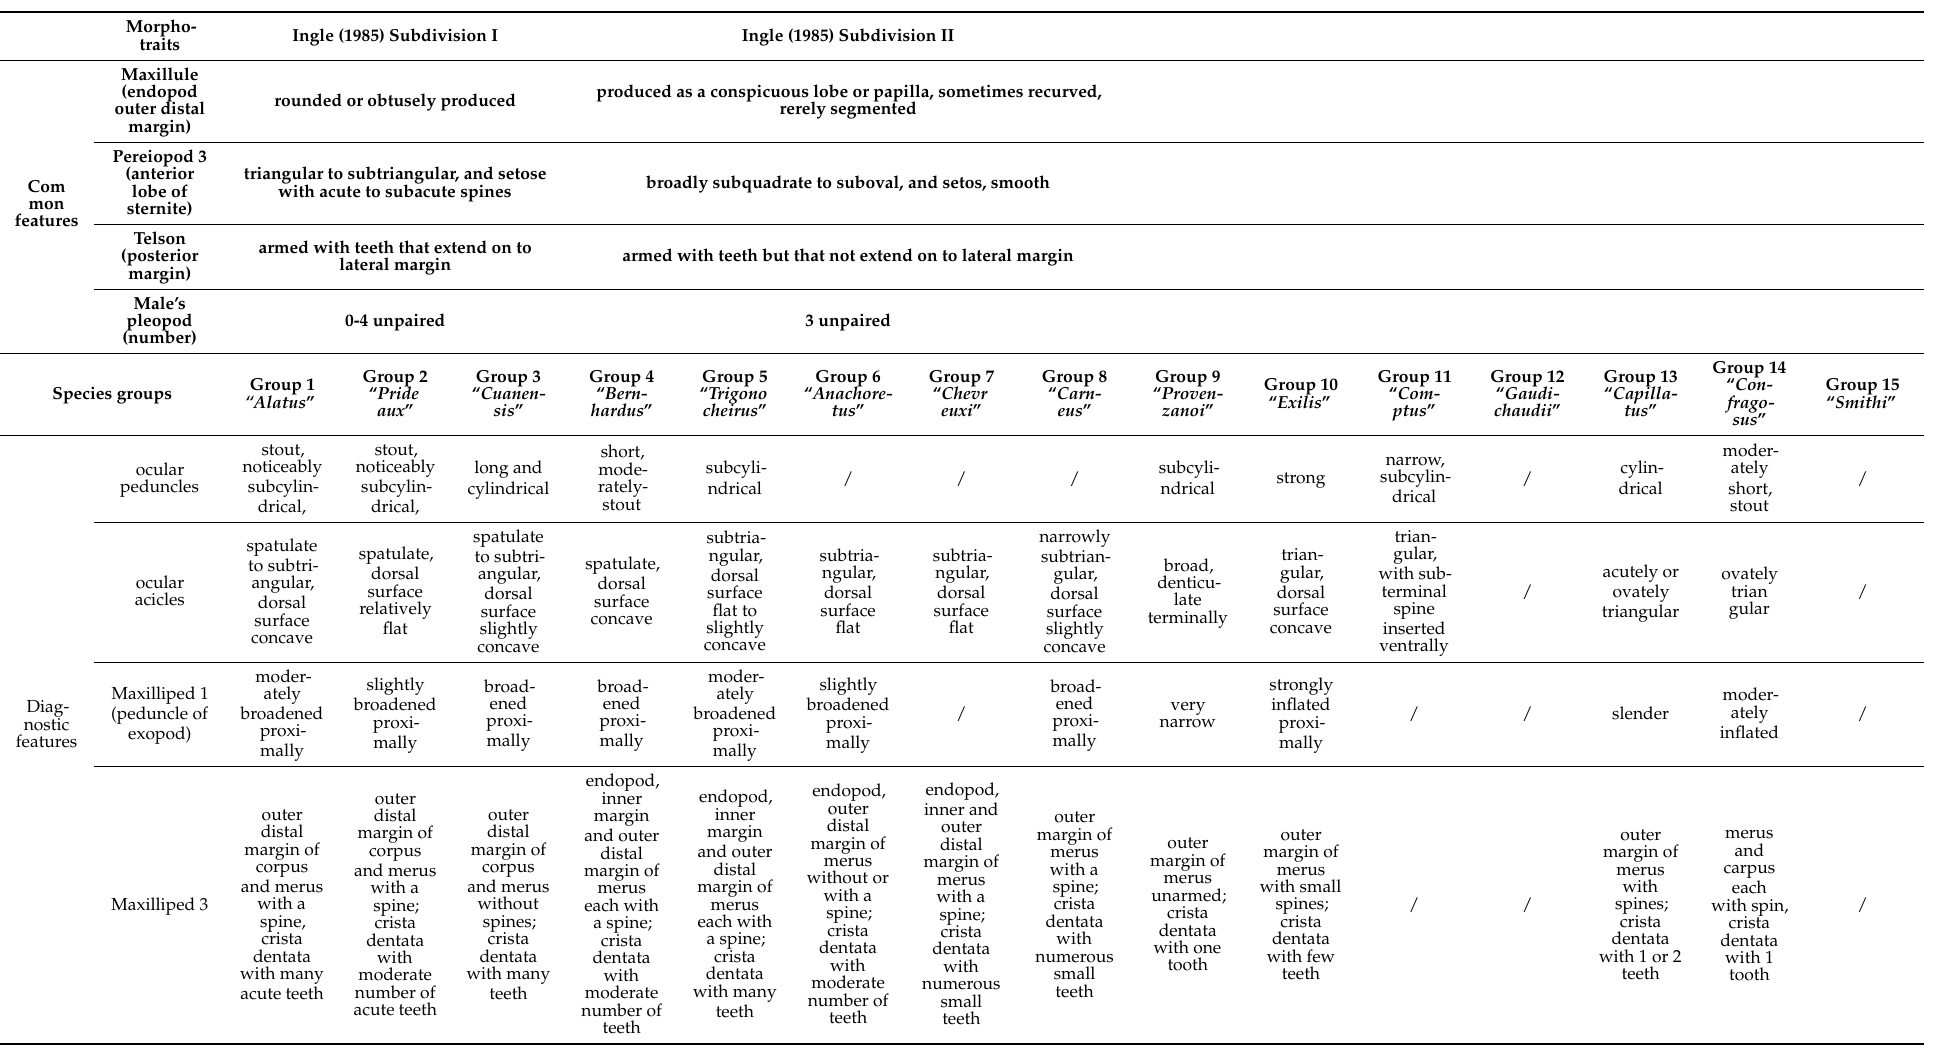
Table 3. Variabilities in morphological features among species groups of the genus Pagurus